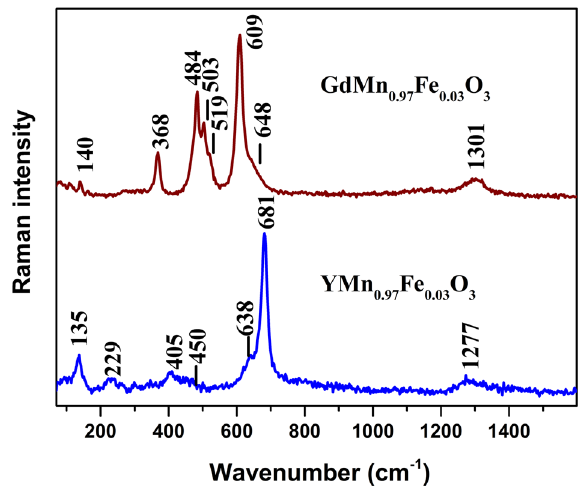
Figure 3. Raman spectra of polycrystalline YMn 0.97 Fe 0.03 O 3 and GdMn 0.97 Fe 0.03 O 3 . Intensities are normalized to the intensity of the most intense band and spectra are shifted vertically for clarity. The excitation wavelength